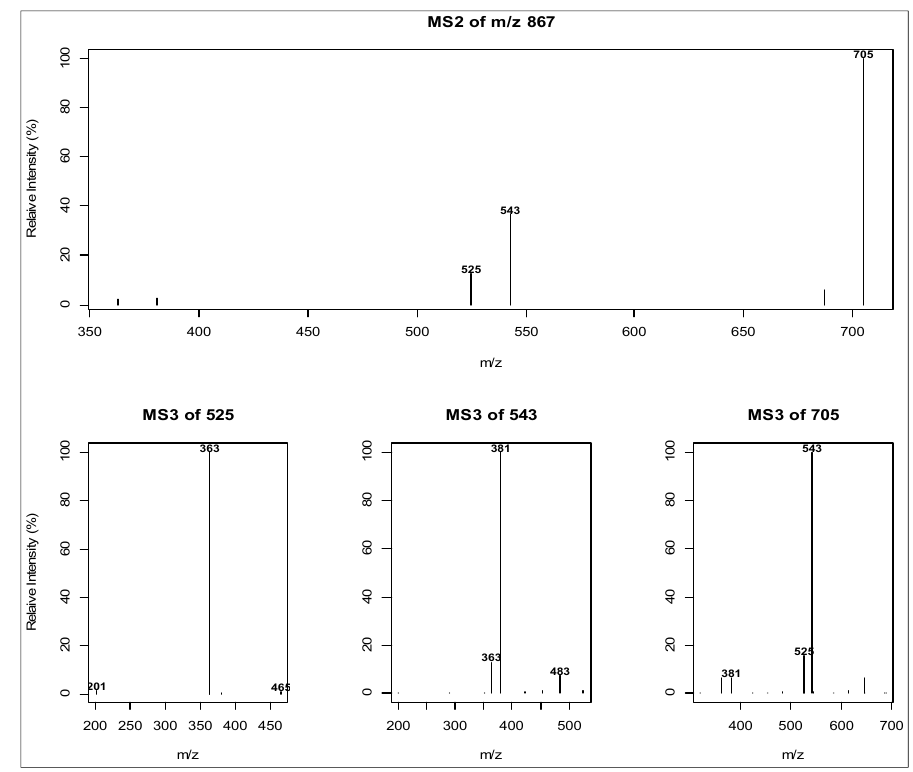
Figure 1. An ion tree derived from the precursor MS 1 ion m/z 867 ± 0.5. The MS 2 spectrum is the average of all MS 2 product ion scans derived from m/z 867 ± 0.5, and the three MS 3 spectra were derived from all the MS 3 scans with the precursor series (MS 1 –MS 2 ) of m/z 867–525, 867–543, 867–705, respectively. m/z 867 is an oligosaccharide with molecular mass of 828 plus a potassium adduct (penta-hexoside, [M+K] + ). Its MS 2 /MS 3 spectra show a series of losses of m/z 162 (hexose-H the proposed